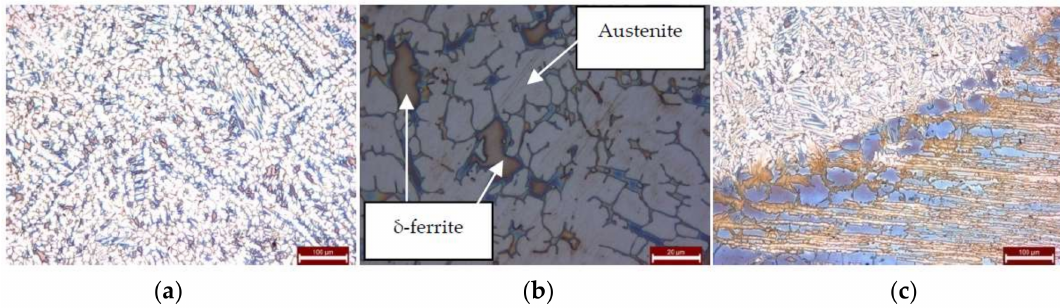
Figure 7. Micrographs of weldments by Ar + 6% N 2 shielding gas ( a ) weld metal 100 × ( b ) weld metal 500 × ( c ) HAZ 100 × .